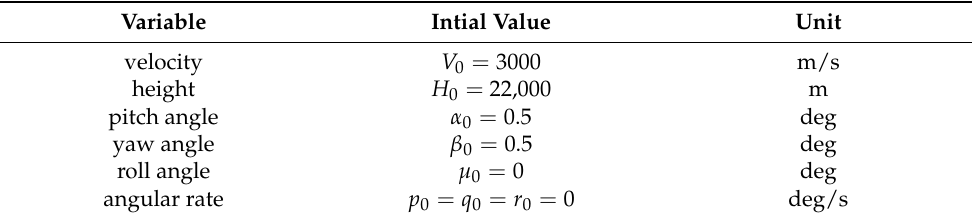
Table 2. Simulation initial